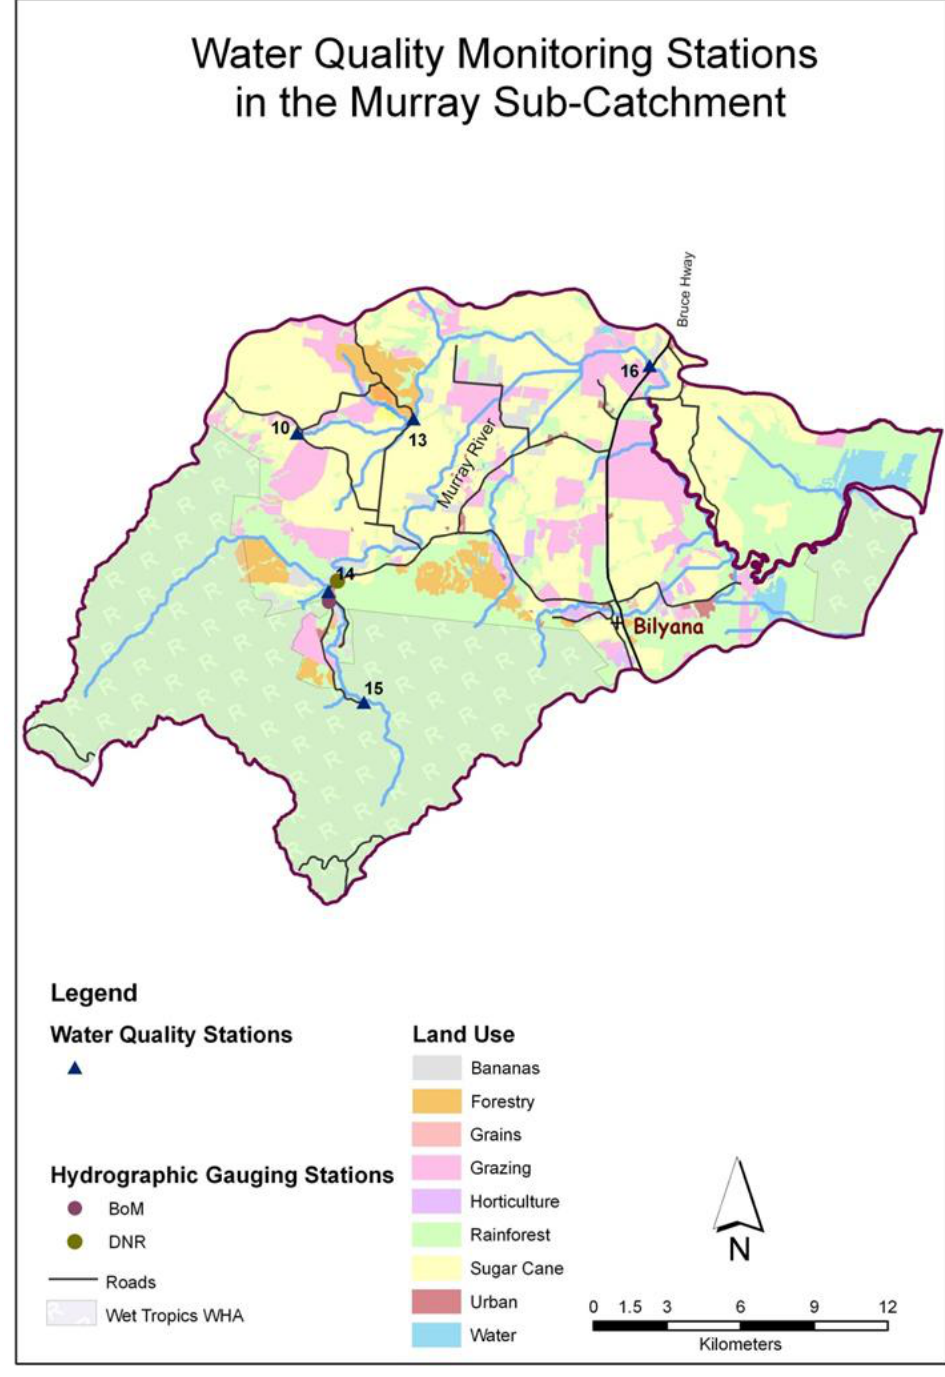
Figure A2. Water quality sampling station locations in the Murray subcatchment.